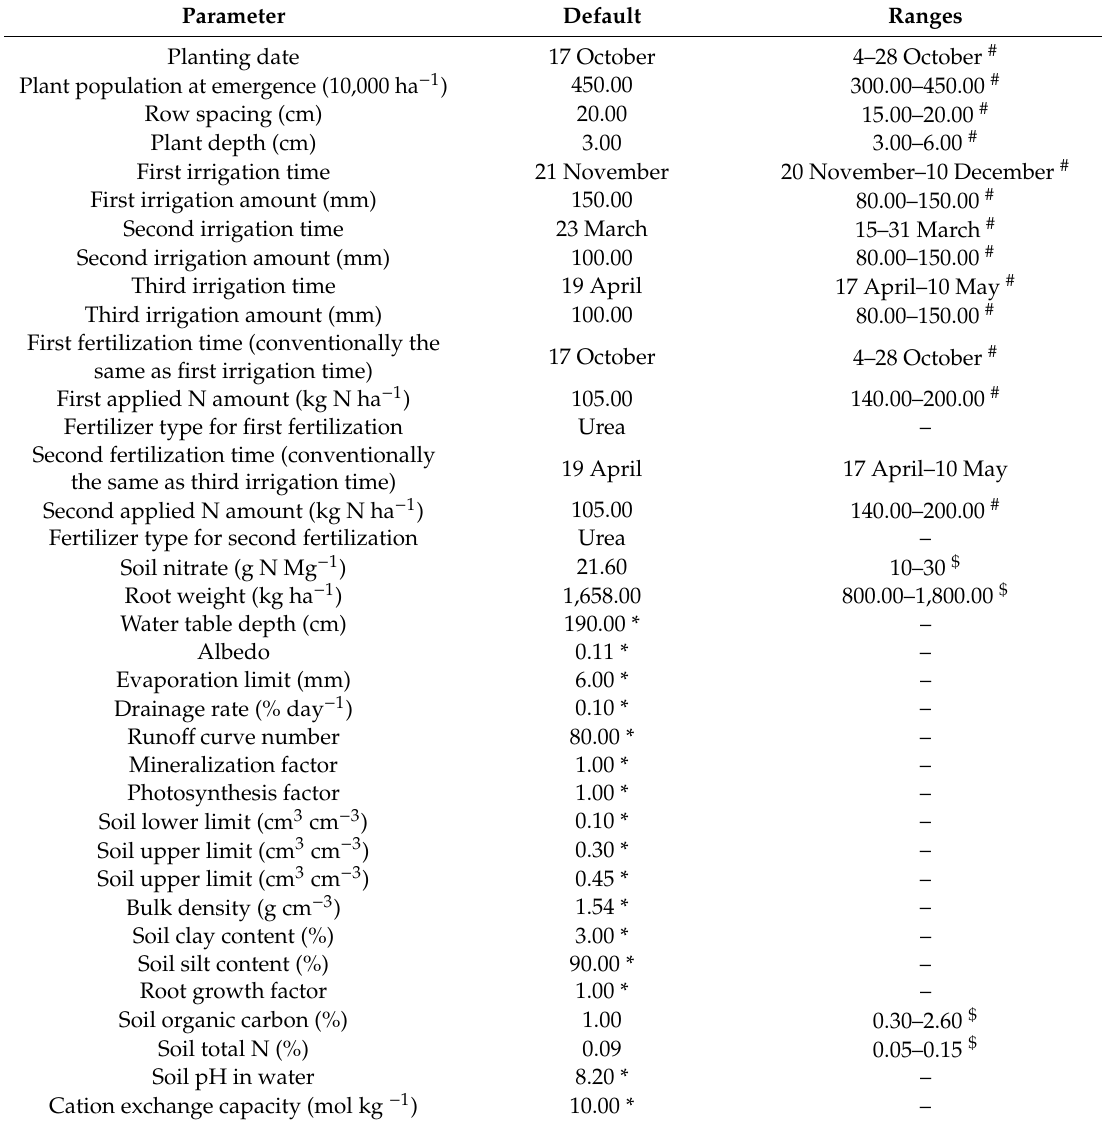
Table 2. Soil and field management parameters in the CERES-Wheat model and